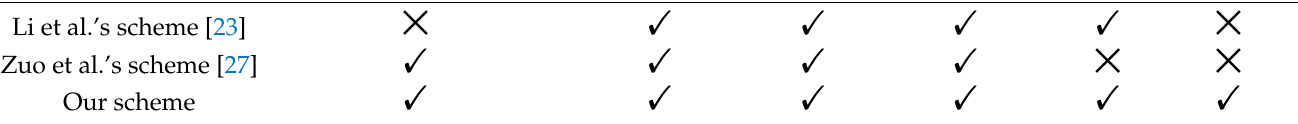
Table 2. Features